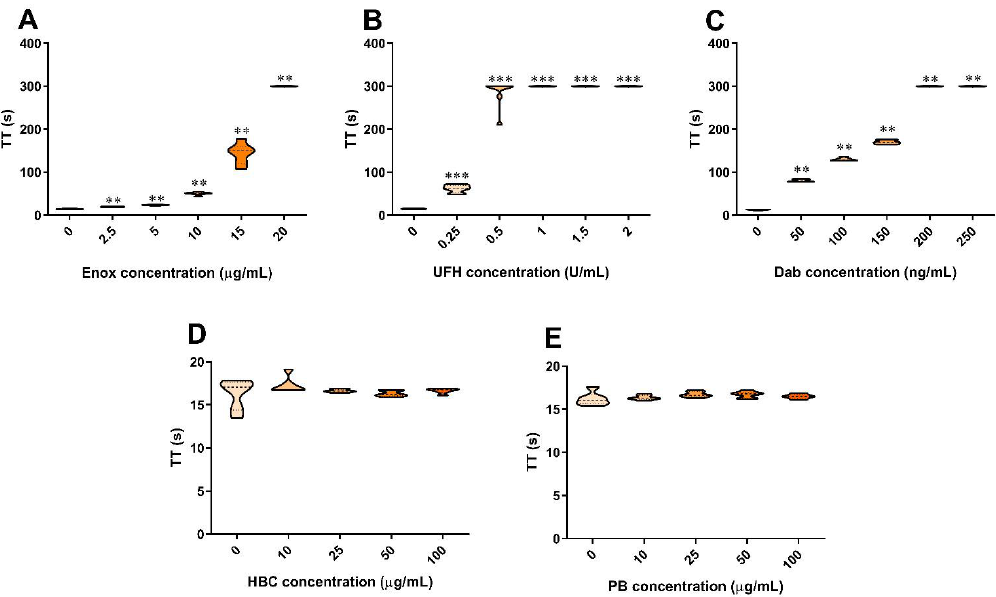
Figure 1. Effect of enoxaparin ( A ), unfractionated heparin ( B ), dabigatran ( C ), HBC ( D ), and polybrene ( E ) on TT in human plasma. ** p < 0.01, *** p < 0.001 vs. control, Mann–Whitney test. The results are shown as violin plots with minimum and maximum values and analyzed with GraphPad Prism 8 software. Dab, dabigatran; Enox, enoxaparin; HBC, heparin-binding copolymer; PB, polybrene; TT, thrombin time; UFH, unfractionated heparin.